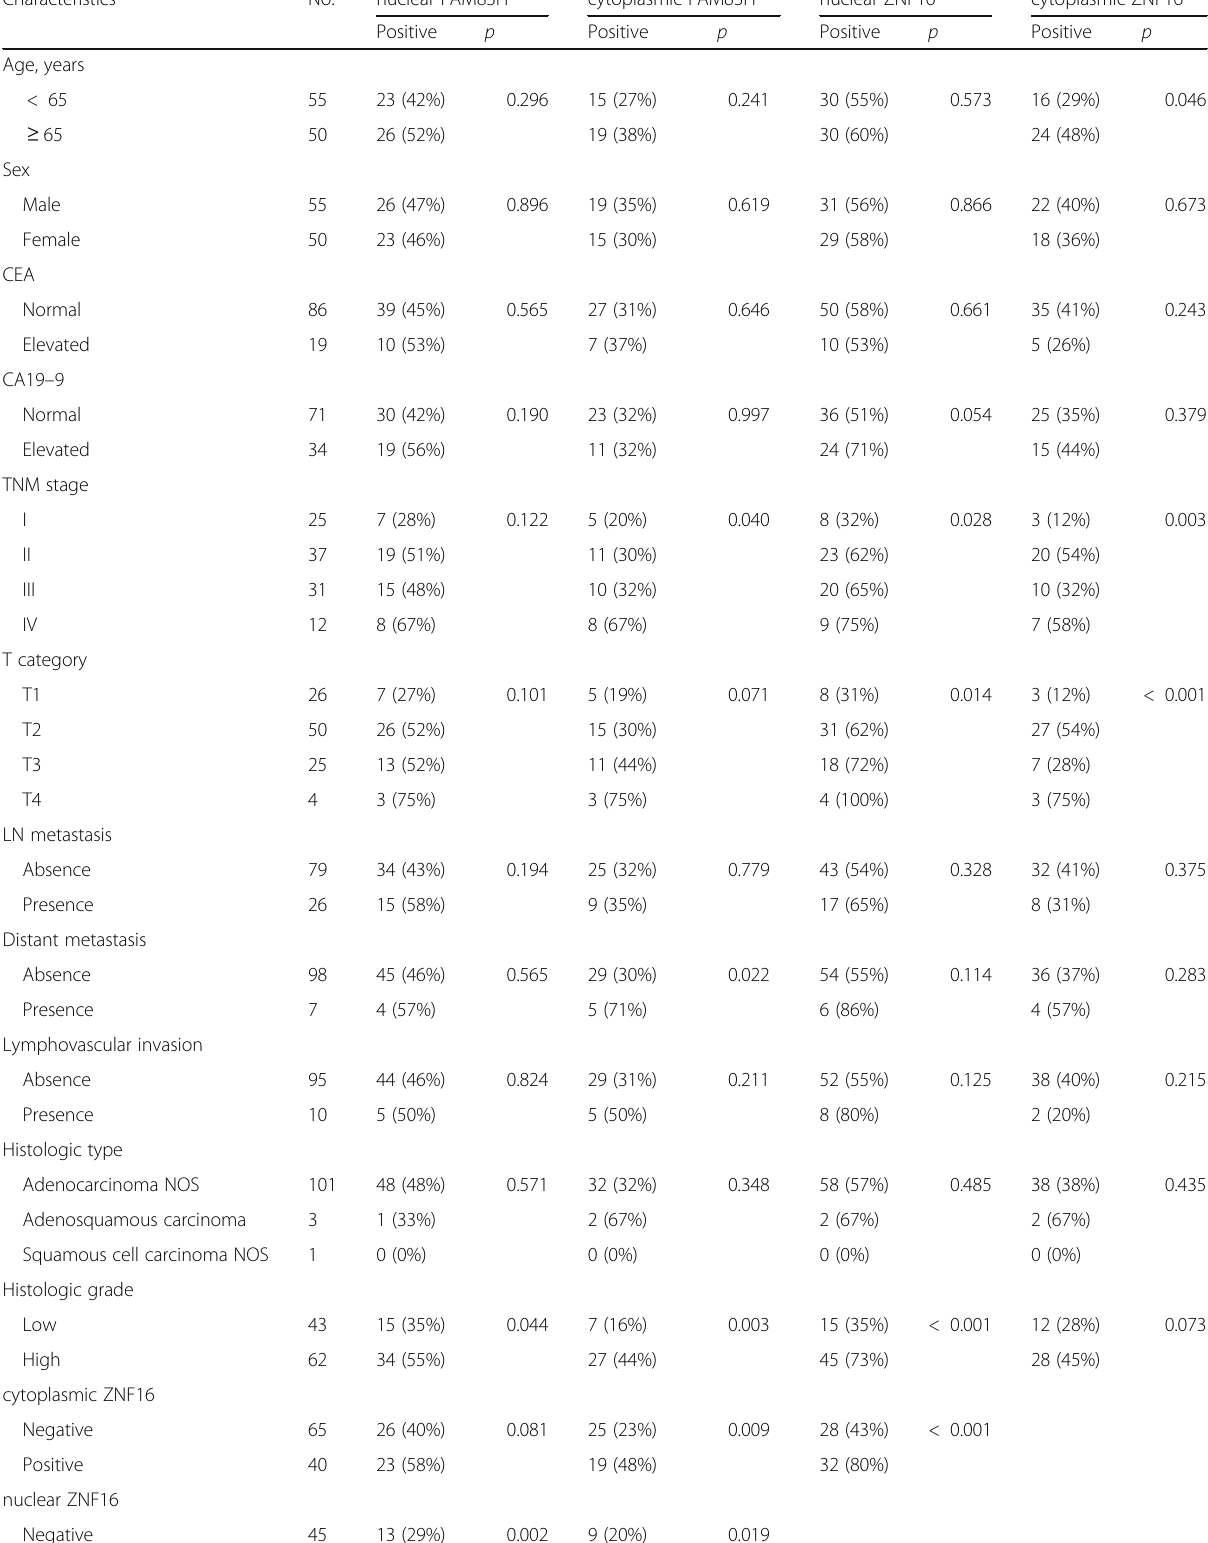
Table 1 Clinicopathologic variables and the expression of FAM83H and ZNF16 in gallbladder carcinomas